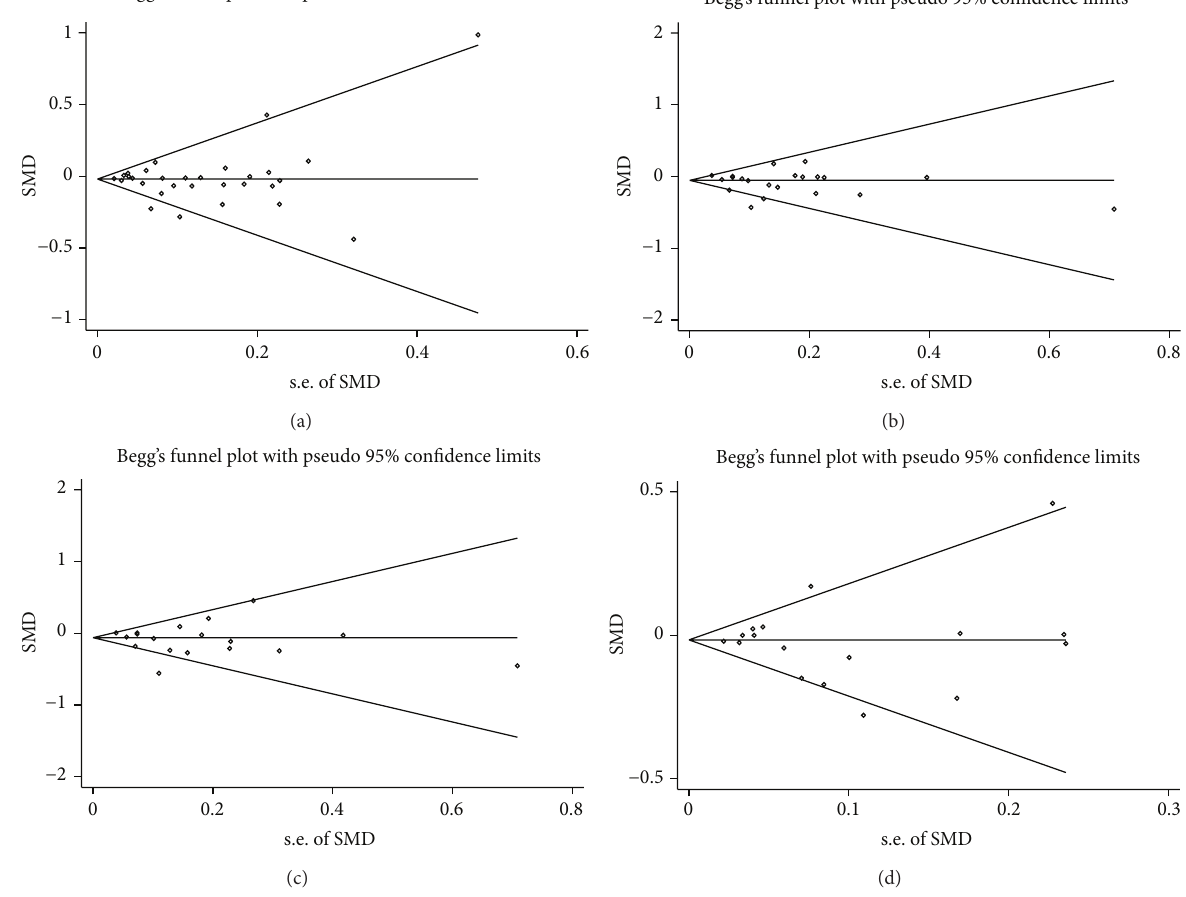
Figure 3: Funnel plot of TGCF7L2 rs7903146 polymorphism and triglyceride association in dominant model (a), recessive model (b), homozygous recessive model (c), and heterozygous model